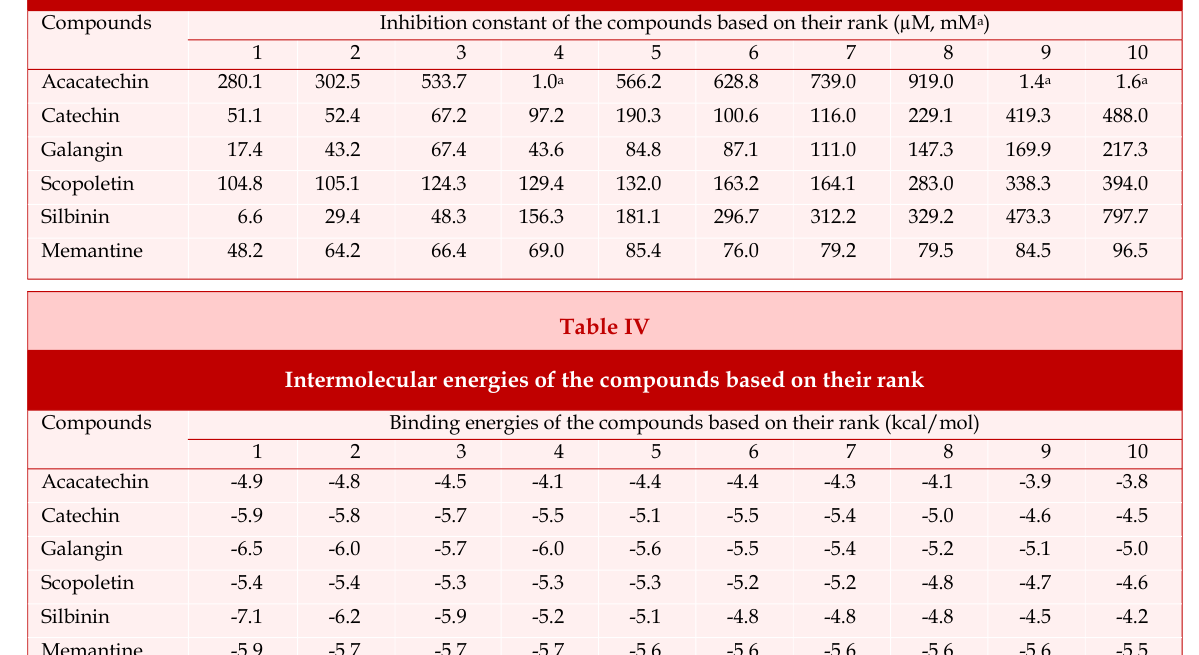
Inhibition constant of the compounds based on their